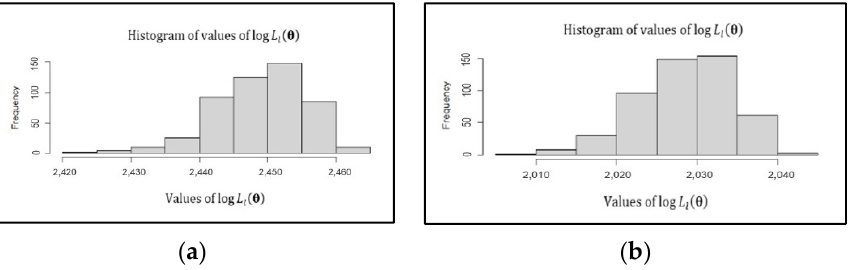
Figure 7. Histogram of values of log L l ( θ ) , ( a ) for 𝓀 = 500, m = 9, l = 10, n = 115; and ( b ) for 𝓀 = 500, m = 10, l = 8, n = 115.